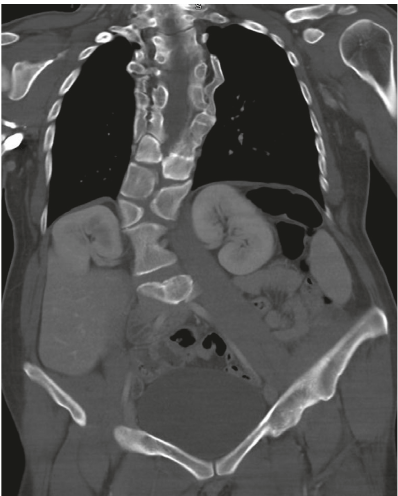
Figure 2: Coronal computed tomography (CT) scan of the chest and abdomen taken at 28 years of age illustrating the vertebral segmentation defects and a stable scoliotic curve. What appeared to be disc spacing has mostly undergone segmental fusions.